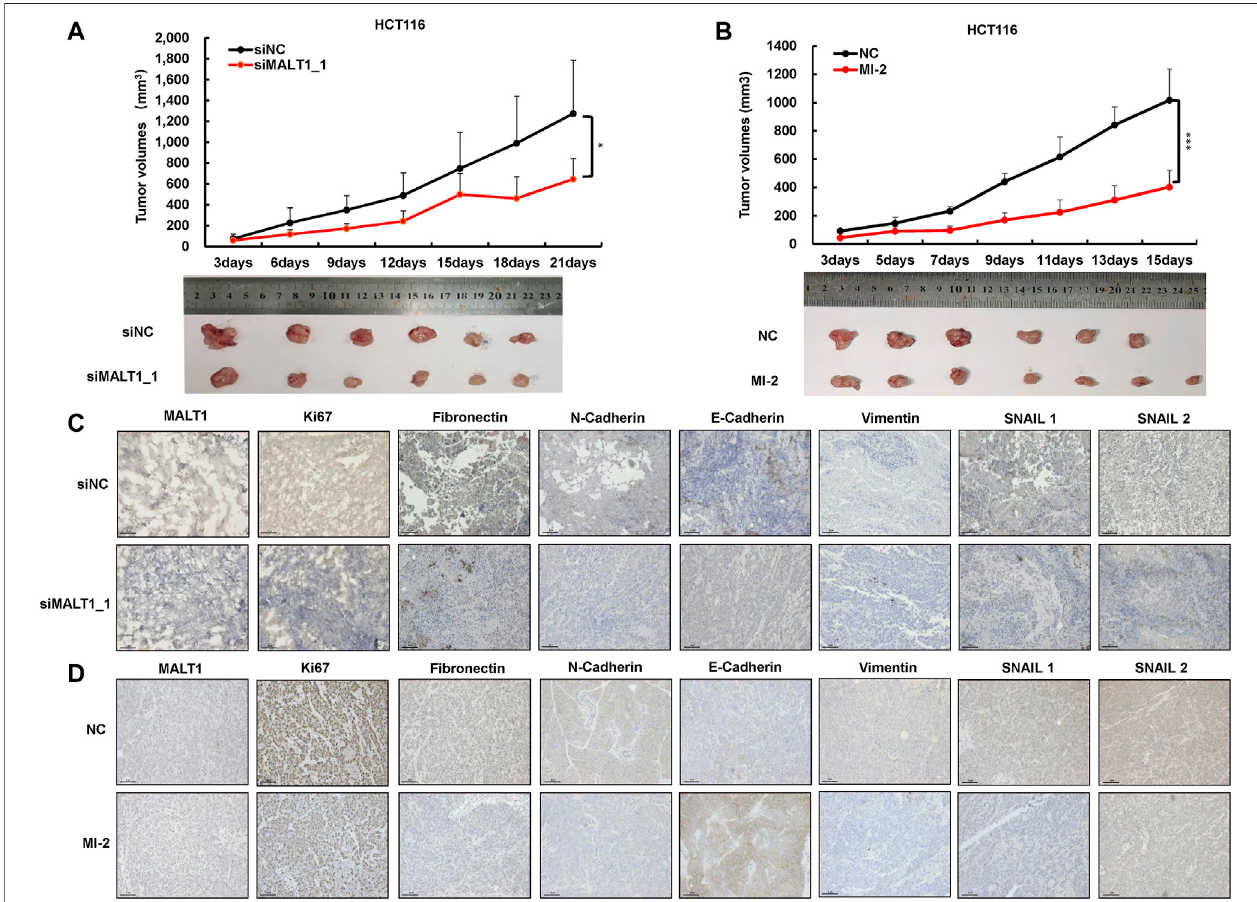
FIGURE 4 | Knockdown of MALT1 inhibited CRC progression in vivo . (A) HCT116 cell transfected with siMALT1_1 was used to established subcutaneous tumor growth in a mouse xenograft model. Growth curves of tumor volumes were determined every 3 days. Representative photographs of tumors were shown below. (B) HCT116 cell was used to establish subcutaneous mouse model. After 3 days, mice were randomly divided into NC (5% DMSO) and MI-2 (25 mg/kg) group. Growth curves of tumor volumes were determined every 3 days. Representative photographs of tumors were shown below. (C,D) Representative IHC images of MALT1, Ki67, and on EMT-associated proteins ’ tumor sections. Each experiment was performed in triplicate, and data are presented as mean ± SD. One-way ANOVA and Dunnett ’ s multiple comparison test were used to analyze the data (* p < 0.05, ** p < 0.01, *** p < 0.001).